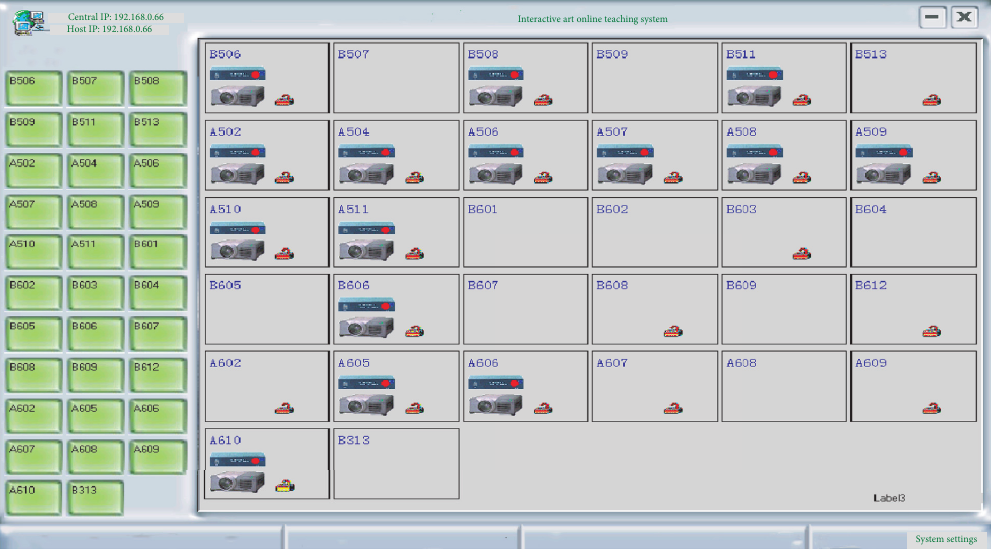
Figure 7: Interactive art online teaching system.